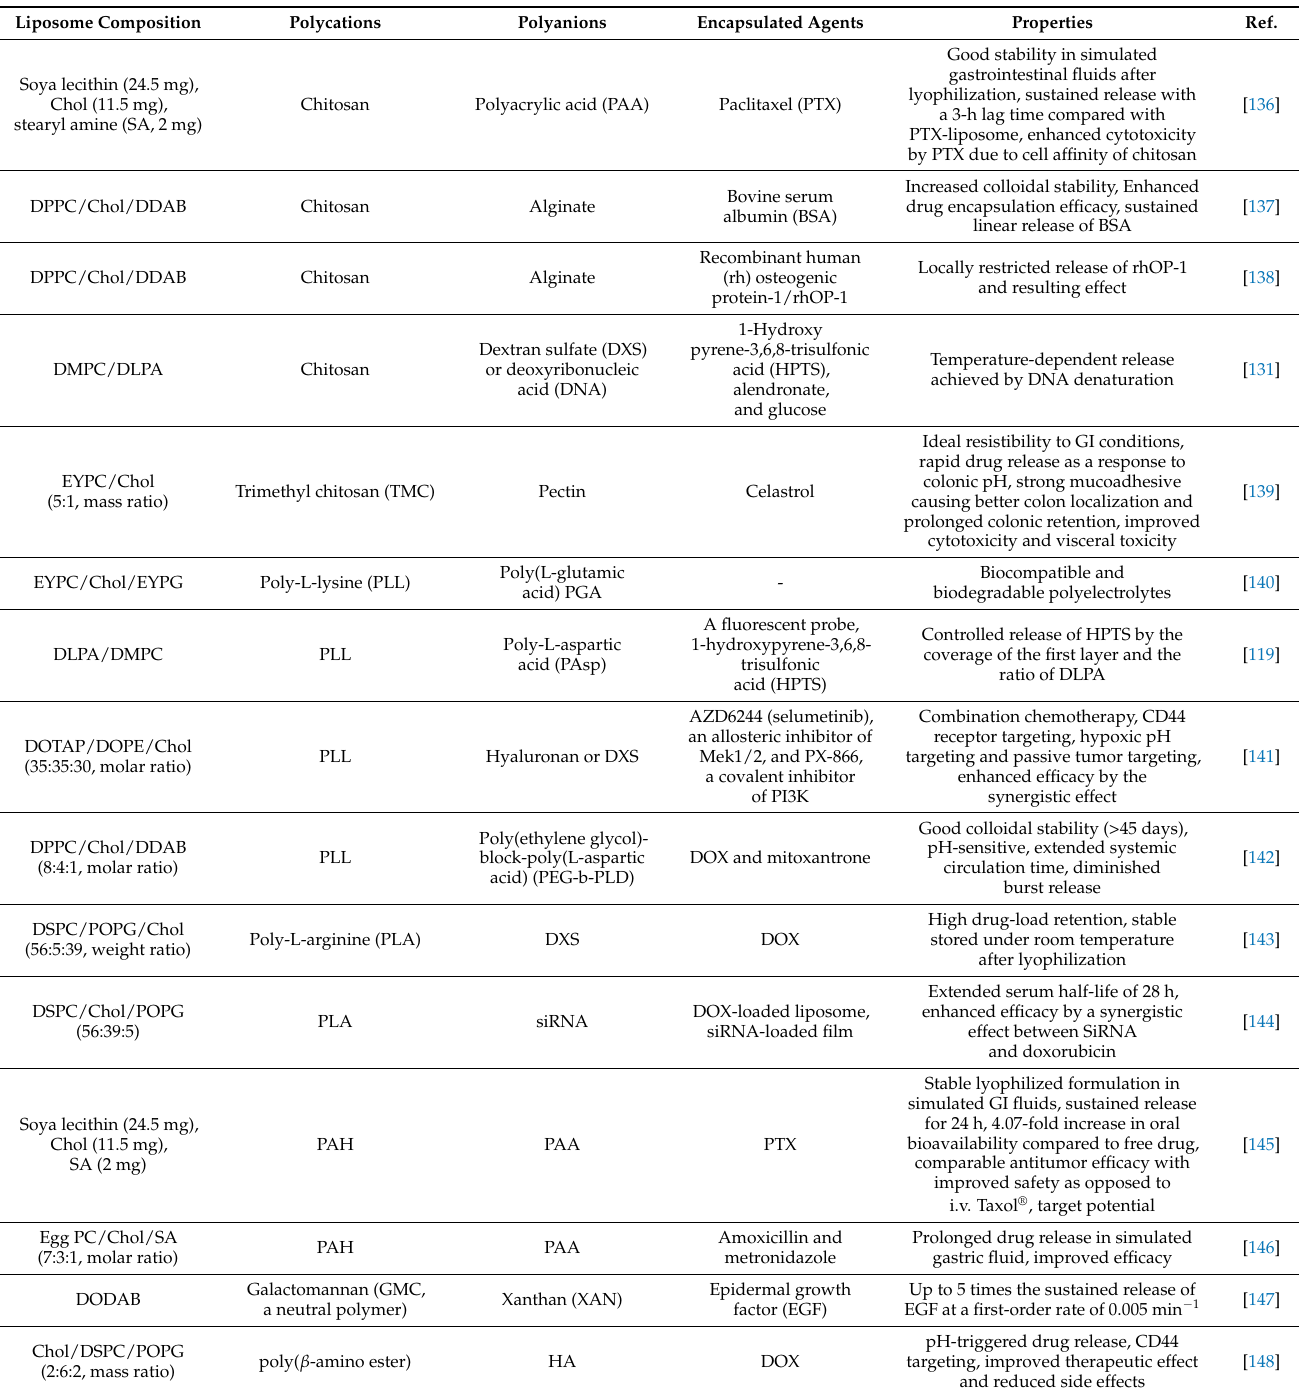
Table 1. Presentative studies on LbL-coated liposomal systems designed for drug